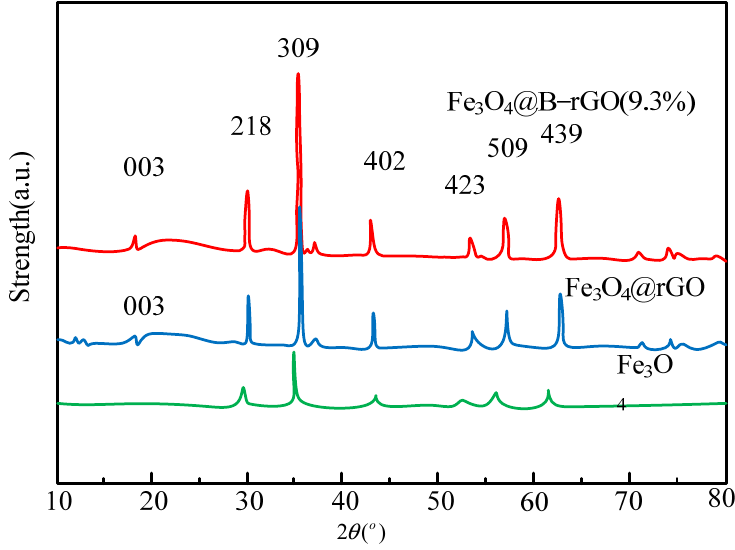
Figure 3. XRD patterns of Fe 3 O 4 @B-rGO (9.3%), Fe 3 O 4 @rGO and Fe 3 O 4 .